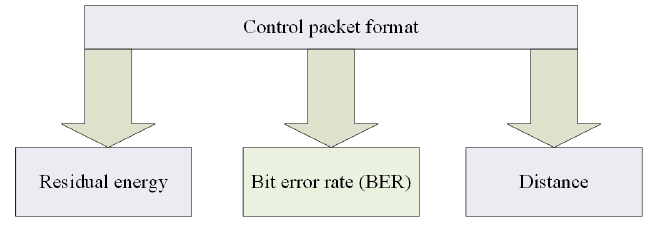
Figure 2. Control packet (CP)